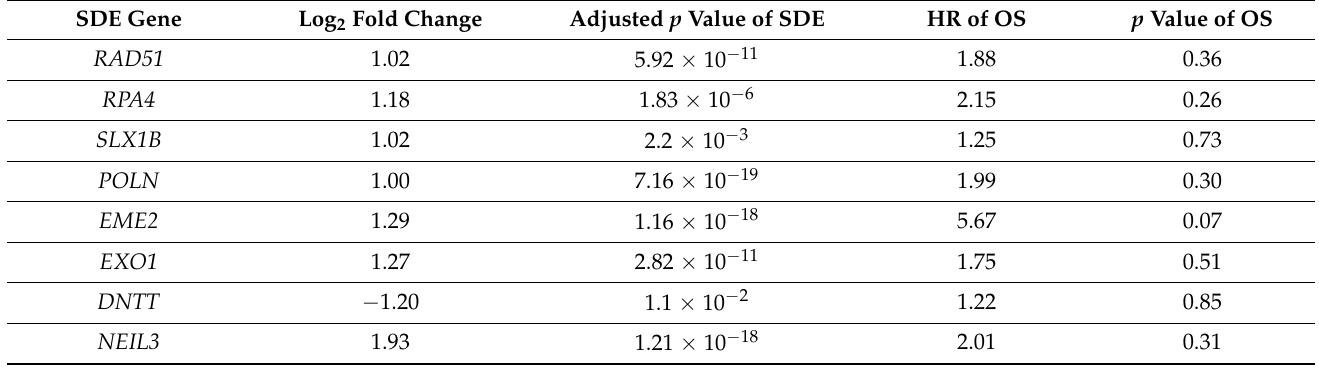
Table 1. The log 2 fold change and corresponding hazard ratio (HR) of overall survival (OS) for each significantly differentially expressed (SDE) gene.